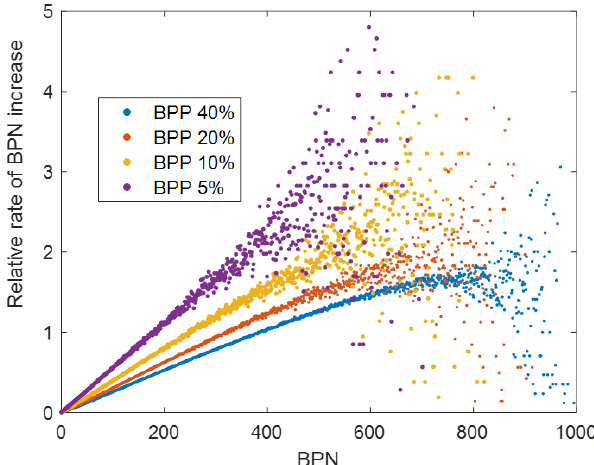
Figure 7. The BPN increase rates for pixel block side length 32 and BPP increasing from 5% to 40% in a binary fashion.